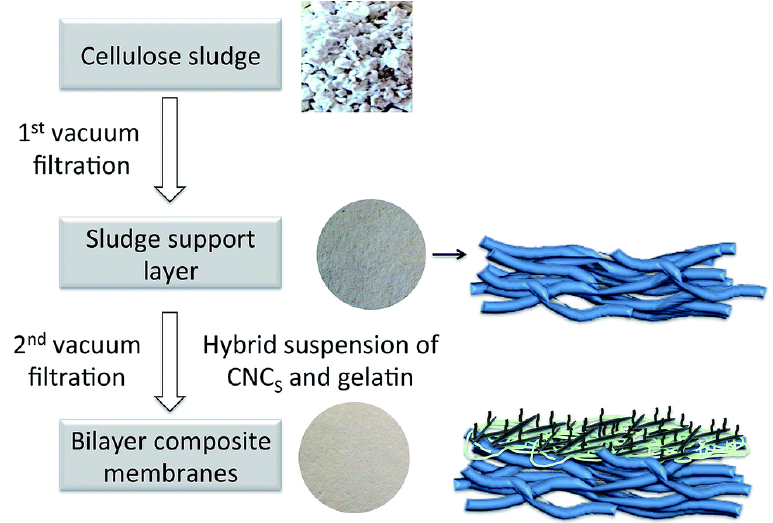
Figure 9. Schematization of the fabrication process of layered cellulose nanocomposite membranes using vacuum-filtration process [142]. Used under CC BY 3.0.